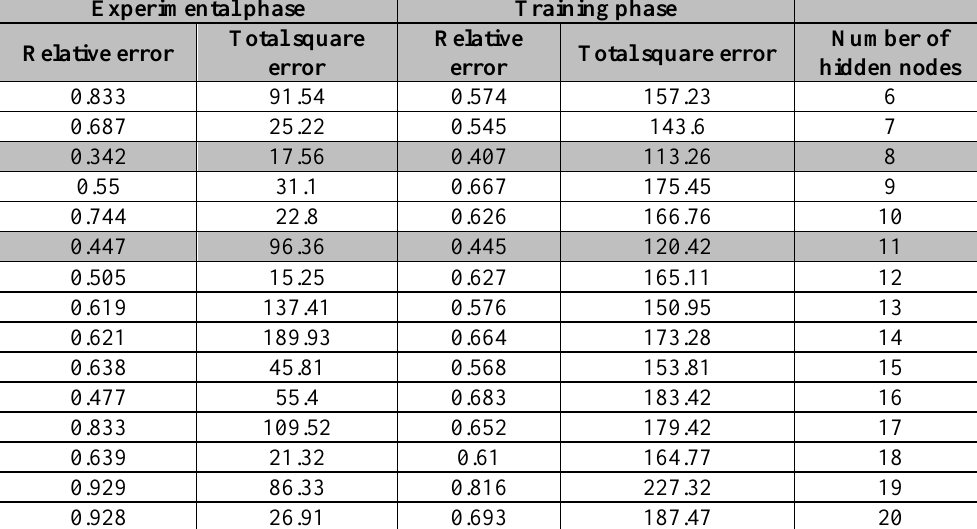
Table 13. Choose the best network structure to predict